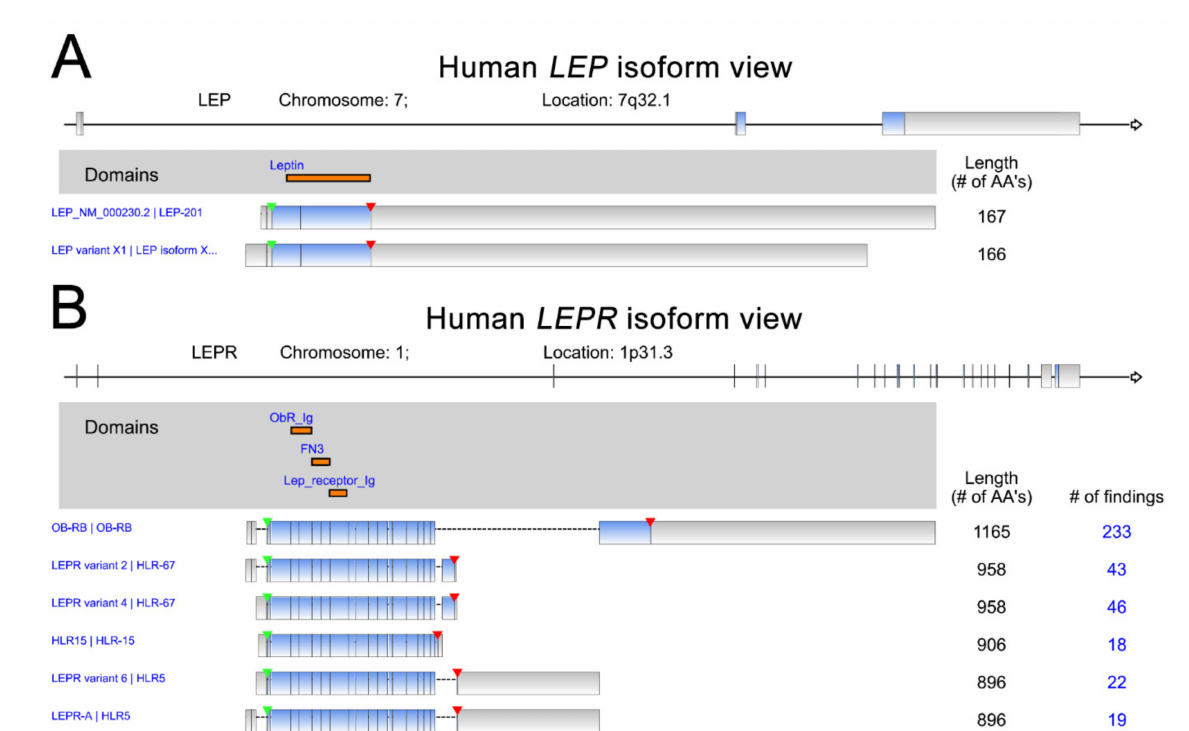
Figure 1. Human LEP ( A ) and LEPR ( B ) isoforms. The data were retrieved and analyzed from RefSeq. The protein domains of various isoforms are indicated in orange. The start of transcription and stop codon position are indicated by green and red arrowheads,